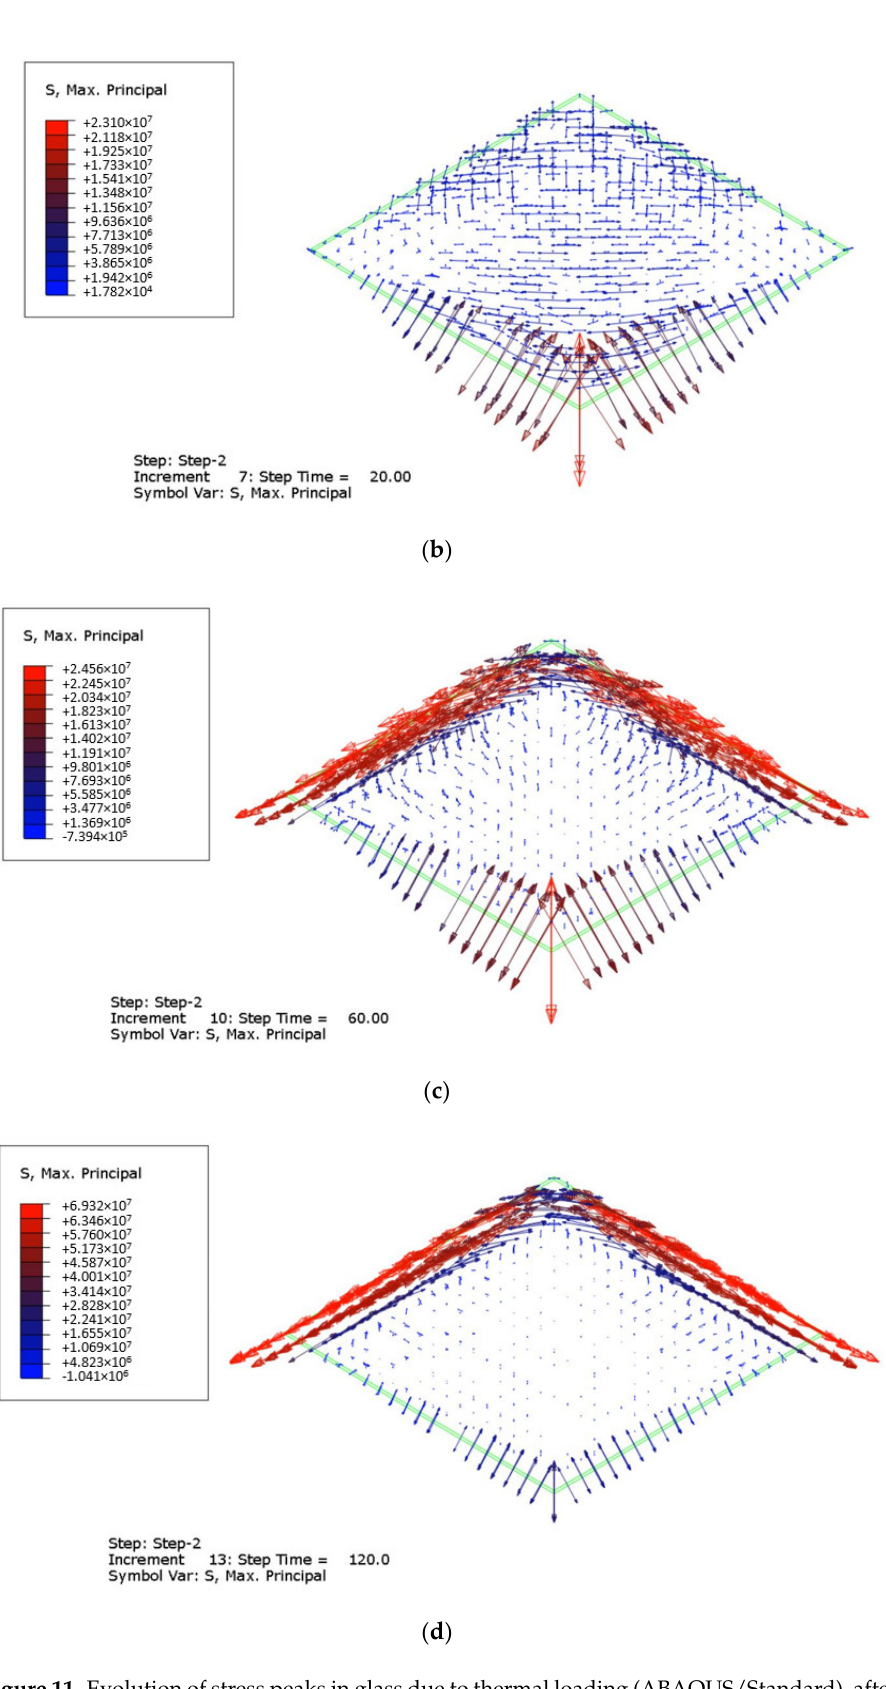
Figure 11. Evolution of stress peaks in glass due to thermal loading (ABAQUS/Standard), after ( a ) 1 s, ( b ) 20 s, ( c ) 60 s, and ( d ) 120 s in fire conditions. Legend in